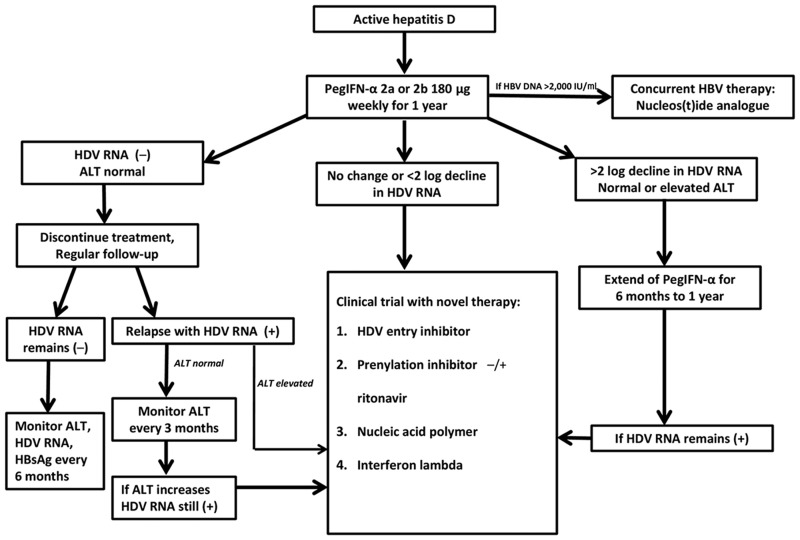
Algorithm for the treatment of chronic hepatitis D